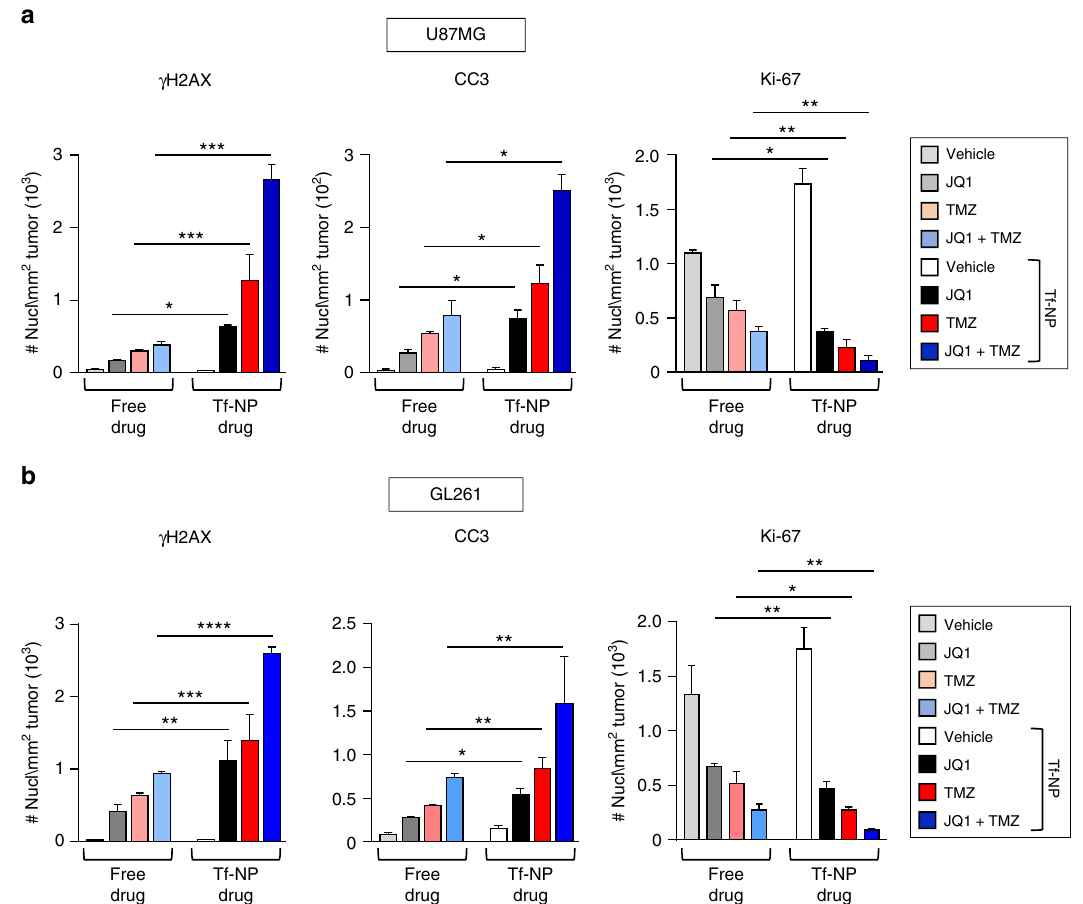
Fig. 6 U87MG and GL261 mice treated with dual drug-loaded Tf-NPs demonstrate increased DNA damage and apoptosis in tumors. Quanti fi cation of number of tumor cells that stained positive for markers of DNA damage ( γ H2AX), apoptosis (CC3), and proliferation (Ki67) in a U87MG and b GL261 mice that received free drug vs liposome-loaded drug (Tf-NP). Signal intensity was quanti fi ed from >300 cells in tumors of three mice per treatment condition using ImageJ. Data presented as mean ± SEM (* p < 0.05, ** p < 0.01, *** p < 0.001, **** p <